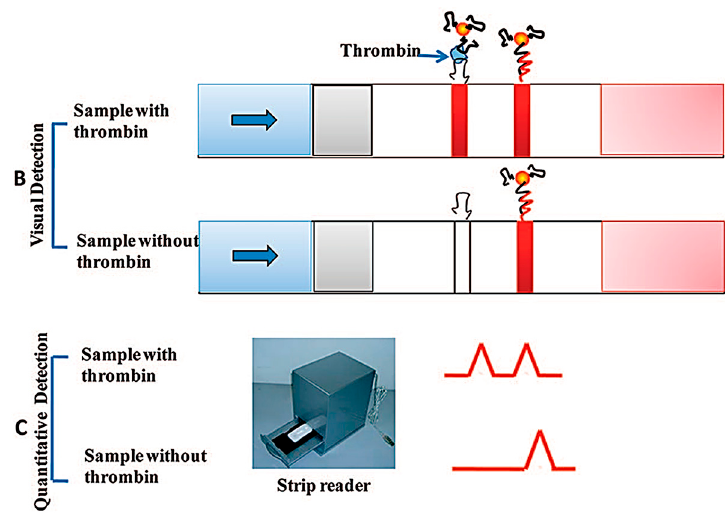
Figure 3. Schematic illustration of the configuration and measurement principle of the aptamer-based strip biosensor: ( A ) configuration of the biosensor; ( B ) the principle of visual detection in the presence and absence of thrombin; ( C ) quantitative detection with a portable strip reader. Adapted from [70].